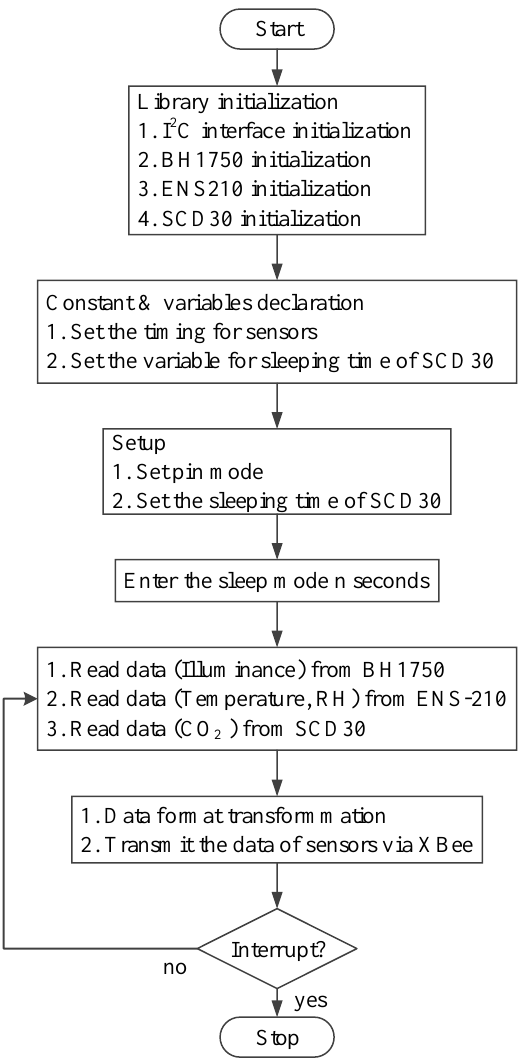
Figure 5. Flowchart of data acquisition for proposed wireless multisensor module.